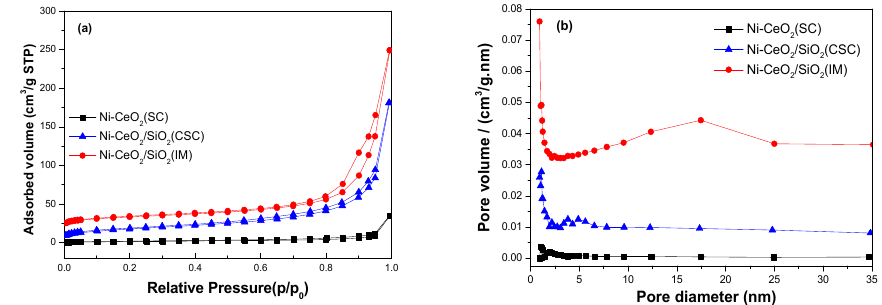
Figure 1. (a) N 2 adsorption–desorption isotherms and (b) the pore size distributions of Ni-CeO 2 -SiO 2 (IM), Ni- CeO 2 -SiO 2 (CSC) and Ni-CeO 2 (SC) catalysts.